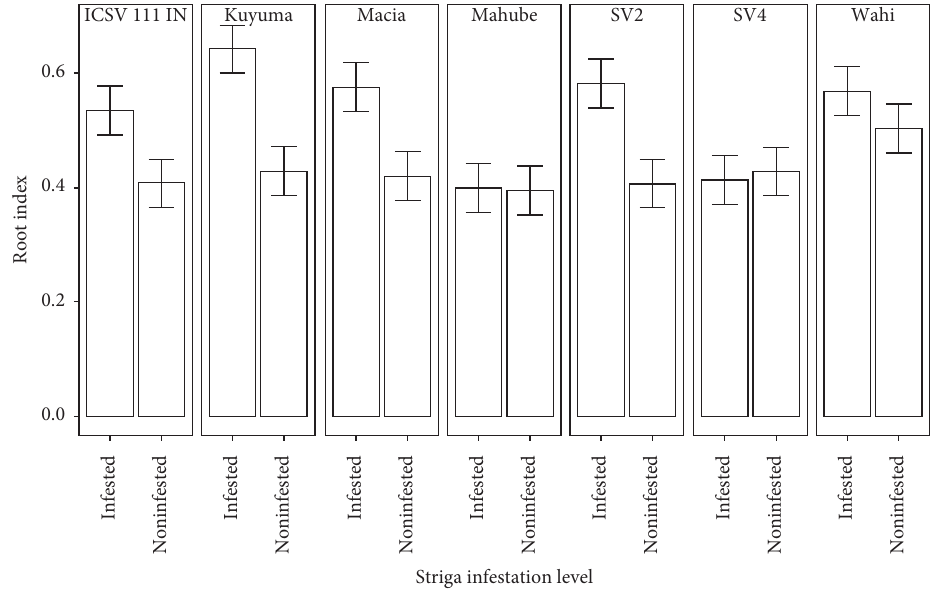
Figure 8: Effect of genotype and Striga infestation on sorghum root index. Error bars represent LSD at p < 0 . 05.